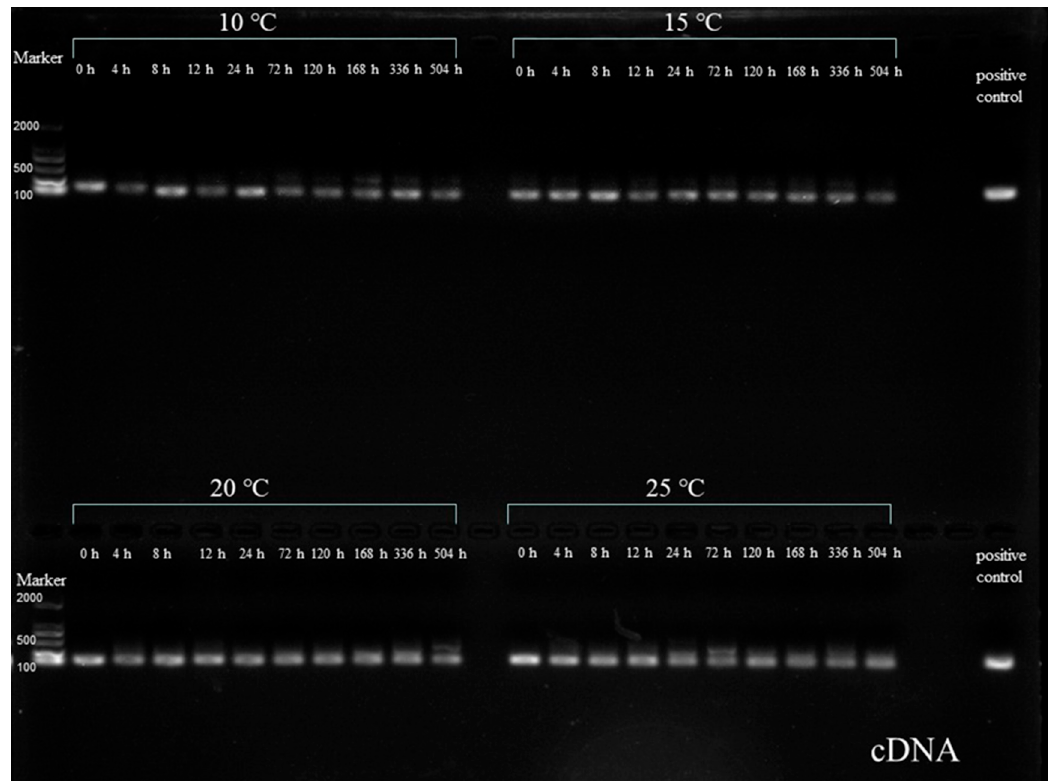
Figure 2. Agarose (2%) gel electrophoresis image of cDNA from reverse-transcribed eRNA from different temperature treatments (10, 15, 20 and 25 °C).